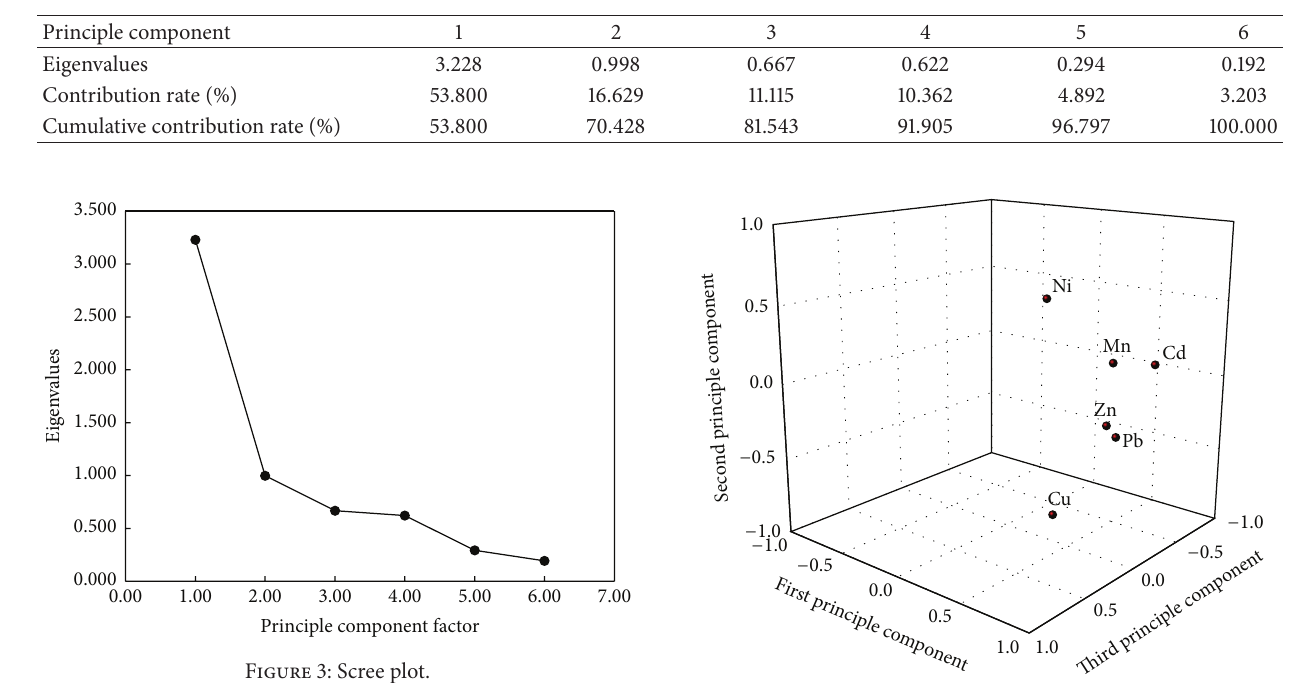
Table 3: Principal component analysis of the metals concentrations.